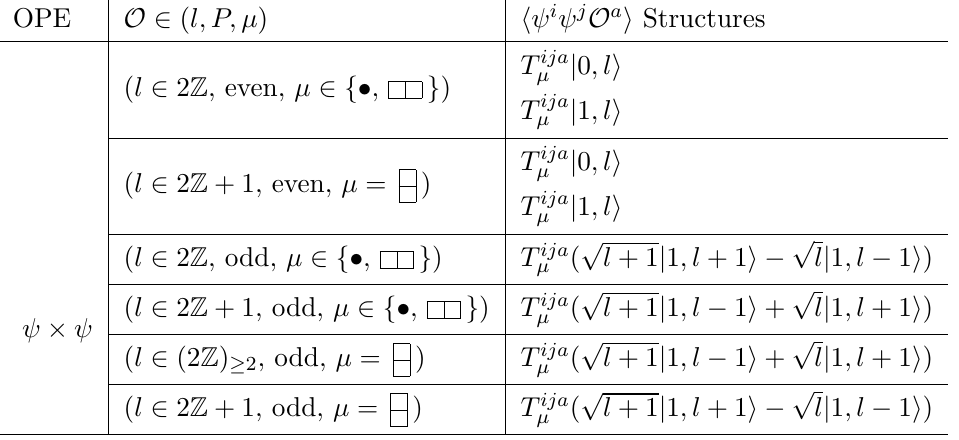
Table 4 . Tensor structures appearing in the OPE of the fermionic